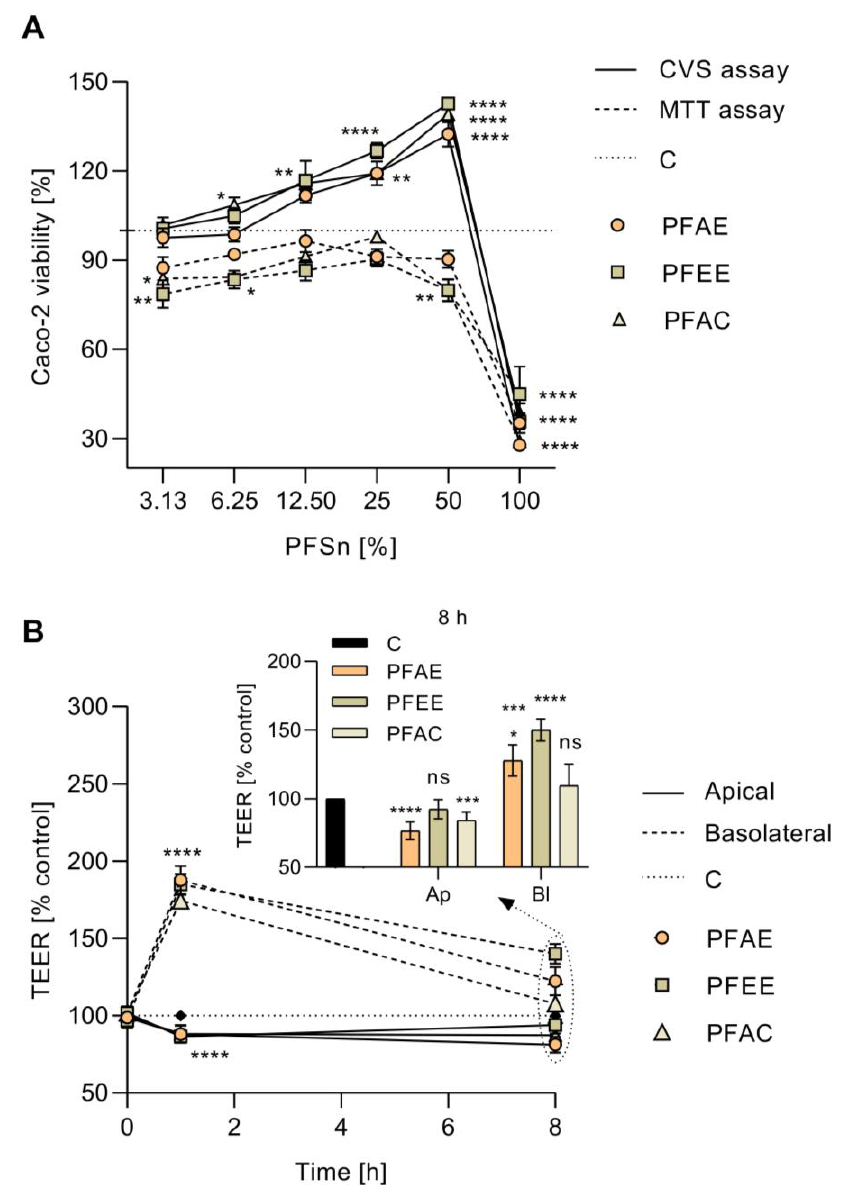
Figure 3. Effect of probiotic fermented supernatants (PFSn) of persimmon fiber (PF) obtained from aqueous extraction (PFAE), ethanolic extraction (PFEE) and acetonic extraction (PFAC) in Caco-2 cells. ( A ) Viability of Caco-2 cells exposed to different concentrations of PFSn of PFAE, PFEE and PFAC by crystal violet staining (CVS) and 3-(4,5-dimethylthiazol-2-yl)-2,5-diphenyltetrazolium bromide (MTT) assays. ( B ) Trans epithelial electronic resistance (TEER) response of Caco-2 cells measured from apical-basolateral (Ap) and basolateral-apical (Bl) directions during 8 h of incubation with PFSn in comparison to untreated monolayers (C) (**** p < 0.0001, *** p < 0.001, ** p < 0.01, * p < 0.05, ns p > 0.05, ANOVA with Dunnett’s post hoc test).